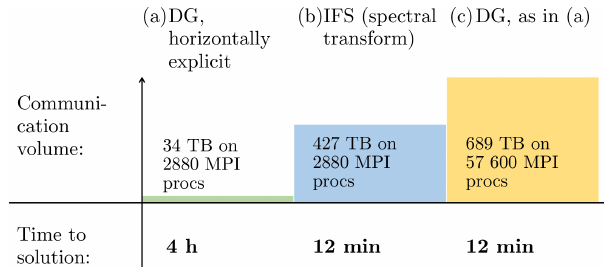
Figure 4. Overall communication volume comparing the spectral element (SEM) from Müller et al. (2018) and the global spec- tral transform methods. The SEM requires a substantially lower amount of communication at the same number of cores, but due to the smaller time step it requires a much higher frequency of re- peated communications for the given 2d simulation. Extrapolating the number of MPI processes to achieve the same time to solution would result in a larger amount of communication for the SEM.